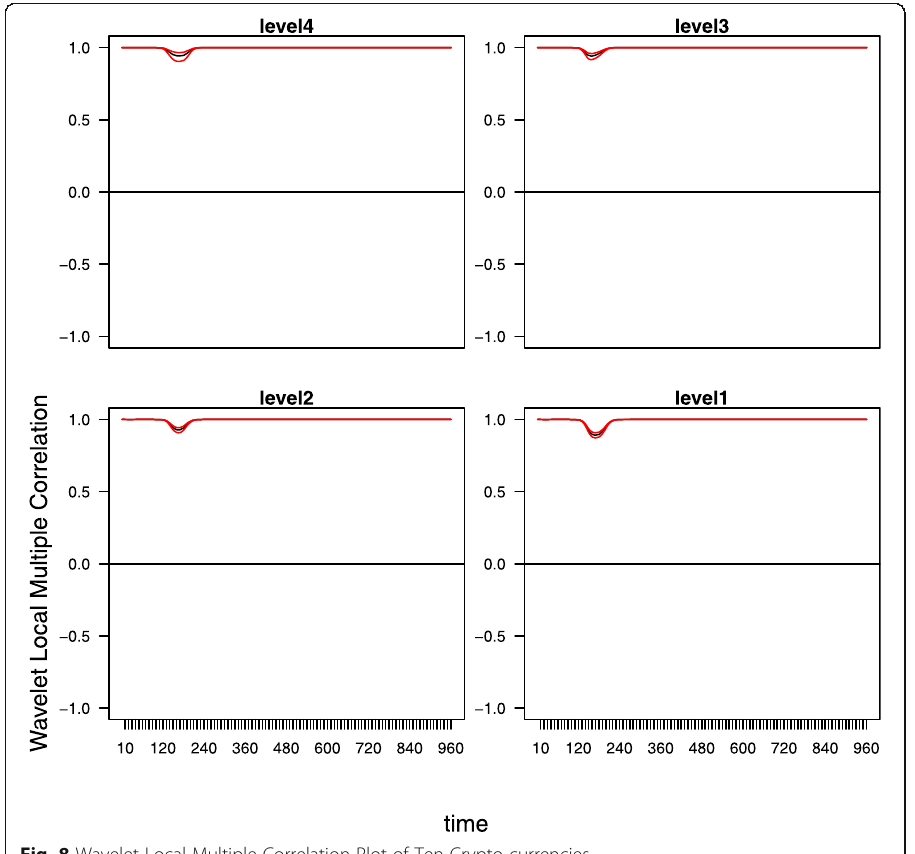
Fig. 8 Wavelet Local Multiple Correlation Plot of Ten